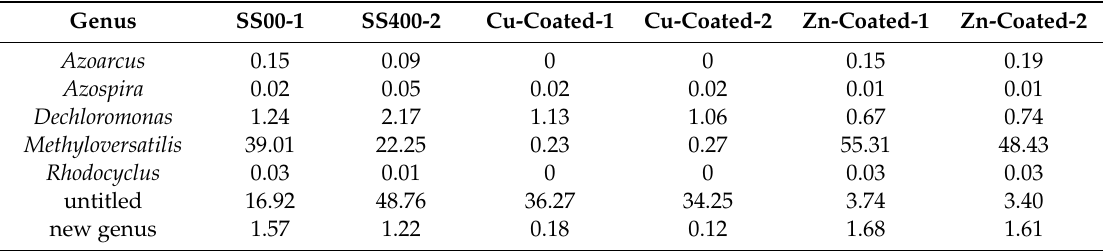
Table 2. The OTU percentages of order Rhodocyclales on post LBR-immersed coupons. All assigned genera are from the family